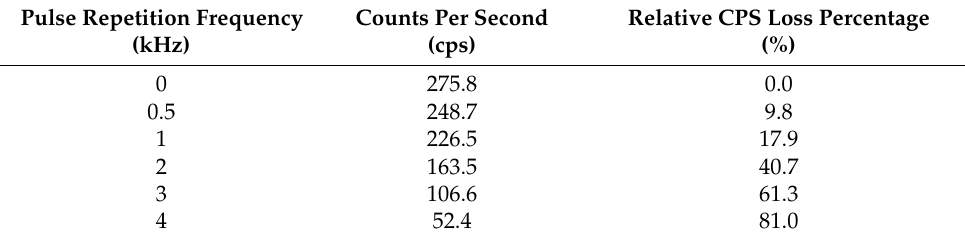
Table 1. Summary of the gamma probe count rate performance at various PRFs of the US transmit- ter